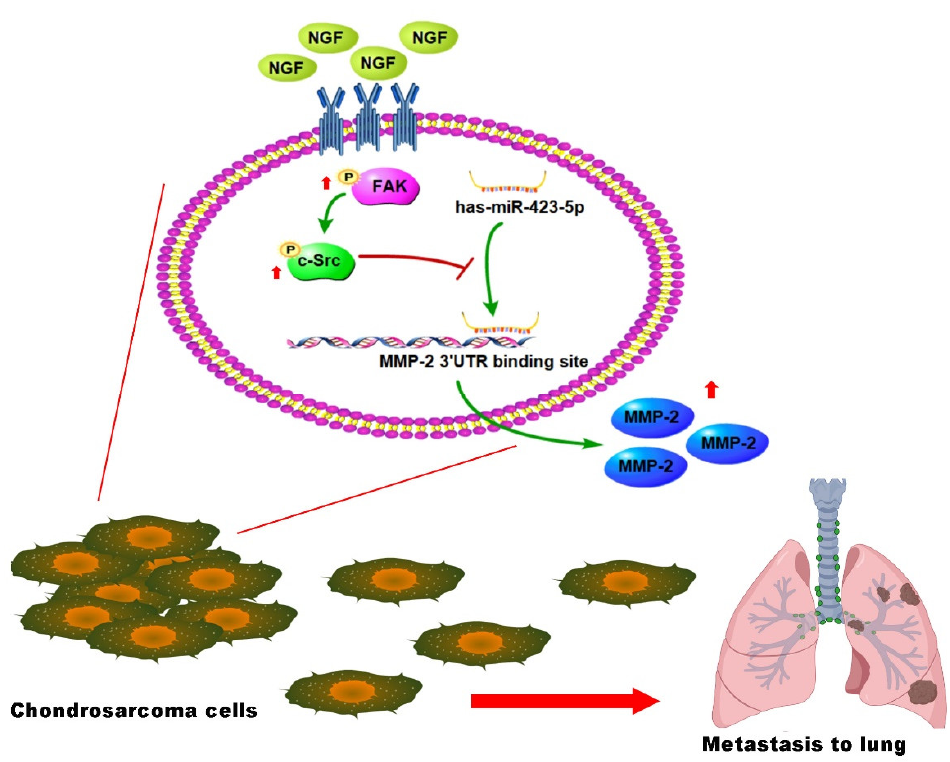
Figure 7. Schema illustrating the effects of NGF in a chondrosarcoma metastasis. NGF facilitates the MMP-2-dependent migratory activities of the chondrosarcoma cells and metastasis by inhibiting the miR-423-5p synthesis via the FAK and c-Src signaling cascades.